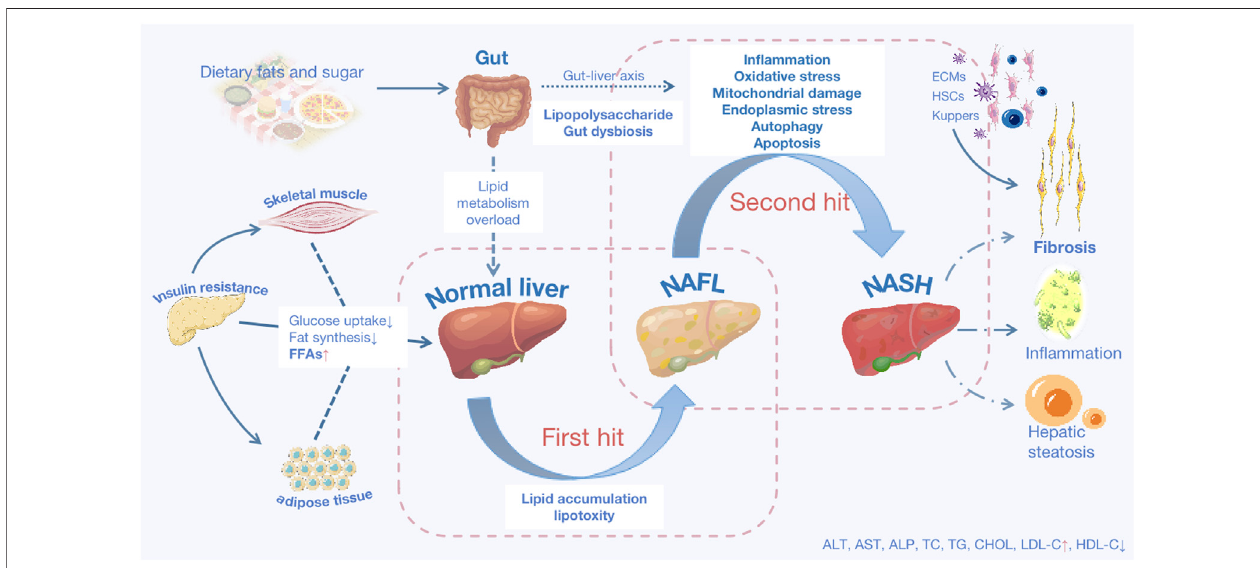
FIGURE 1 | The basic pathological mechanisms of NAFLD. NAFLD is characterized as either non-alcoholic fatty liver disease (NAFL) or non-alcoholic steatohepatitis (NASH) predicated on histological characteristics. Lipid accumulation (LA) is the fi rst hit, and with that lipotoxicity triggered, mainly results from three sources: increased visceral adipose tissue lipolysis, hepatic de novo lipid (DNL) production activation, and excessive fat and calorie intake from diets. Insulin resistance, visceraladiposity,andatherogenicarealllinkedtoaberrantLA.De fi cientinsulinsensitivityinadiposetissueandskeletalmuscle,resultingindecreasedfatsynthesis and glucose uptake,an increase inthe quantity offree fatty acids (FFAs) inthe blood. FFAs enter the liver asaresult ofmetabolic overload,which isthe primary site of fat production. Oxidative stress, endoplasmic reticulum stress, mitochondrial damage, in fl ammatory reactions, fi brosis, and other factors all contribute to the second hit. Excessive deposition of extracellular matrix (ECM), activation of hepatic stellate cells (HSCs) and kupffer cells contribute to fi brosis in long-term chronic in fl ammatory reactions. Steatosis causes autophagy and apoptosis in hepatocytes. AST: aspartate transaminase; ALT: alanine aminotransferase; ALP: alkaline phosphatase; TC: total cholesterol; TG: triacylglycerol; CHOL: cholesterol; LDL-C: low-density lipoprotein cholesterol; HDL-C: high-density lipoprotein cholesterol.